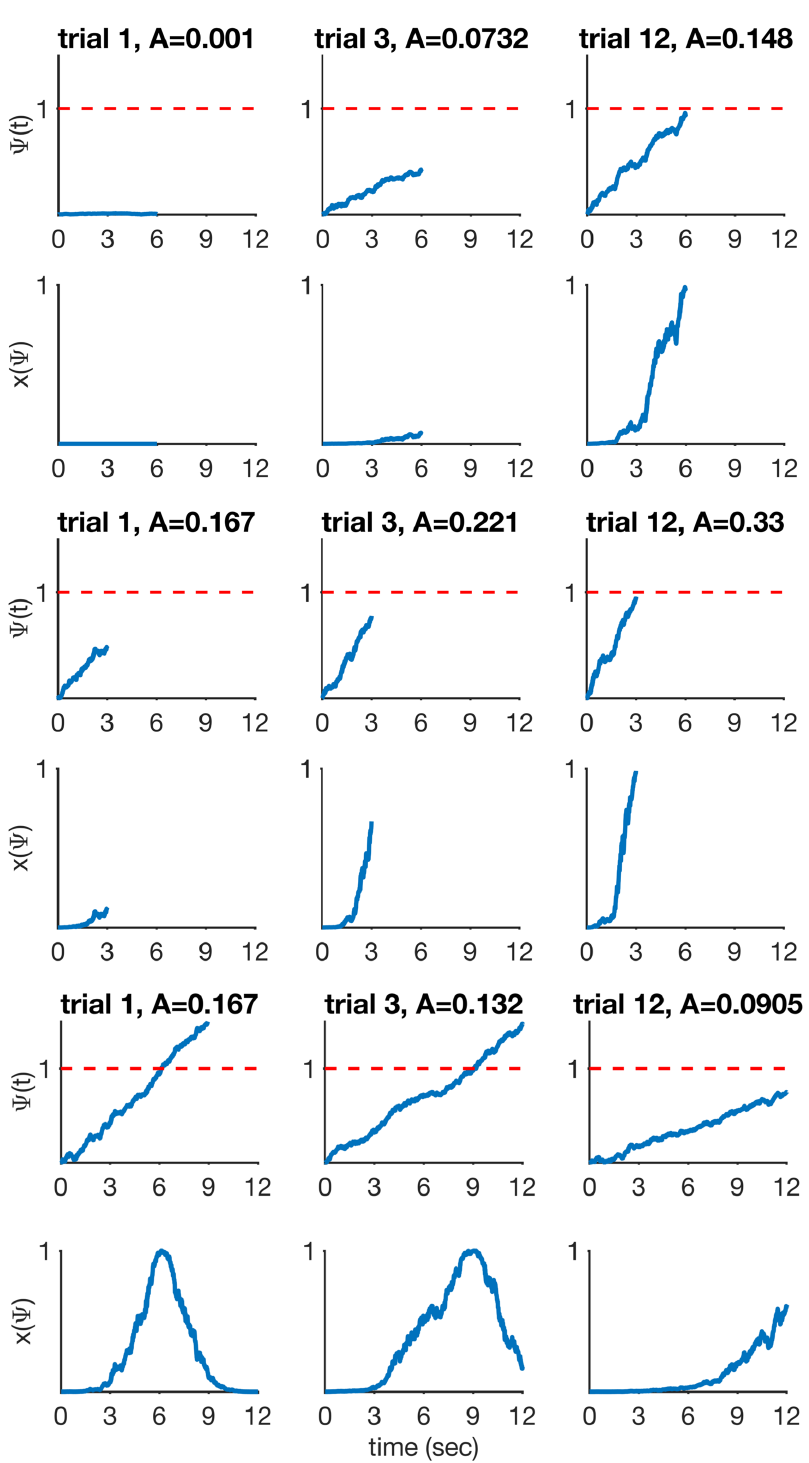
Fig 2. RWDDM timer and CS representation during three 12-trial timing scenarios. Top two rows: timing a novel 6 second stimulus. Timer starts with a low baselineslope ( A = 0.001) on trial 1 and graduallyadapts over trainingto reach approximately the requiredslope. Middle two rows: stimulus durationchangefrom 6 to 3 seconds. Bottom two rows: stimulus durationchangefrom 6 to 12 seconds. Parameters: α t = 0.215, θ = 1, σ = 0.25, m =